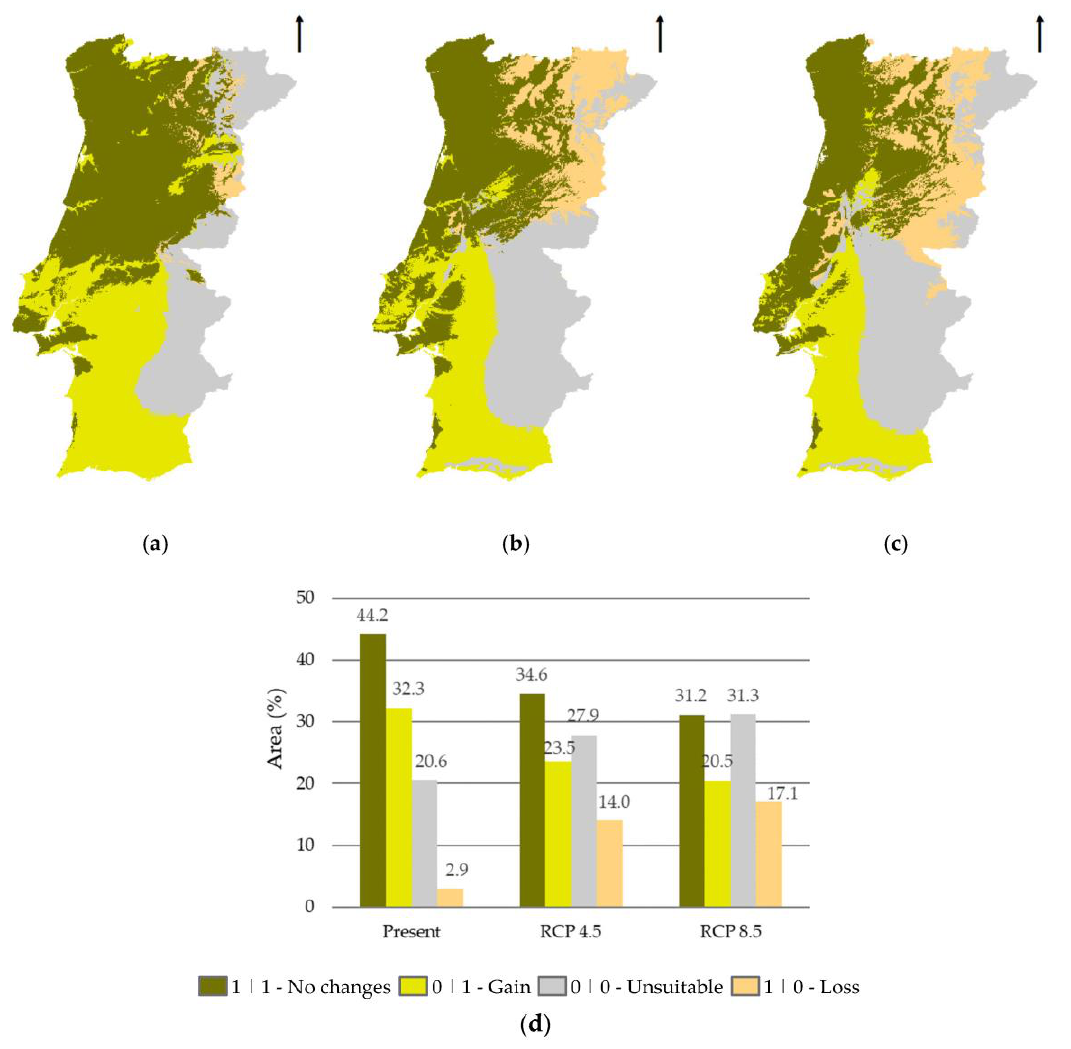
Figure 11. MaxEnt vs. ecological envelope — Maritime pine ’ s presence – absence maps combined: ( a ) Present; ( b ) Future (2070) — RCP 4.5; ( c ) Future (2070) — RCP 8.5; and ( d ) No changes, gain, unsuitable and loss areas